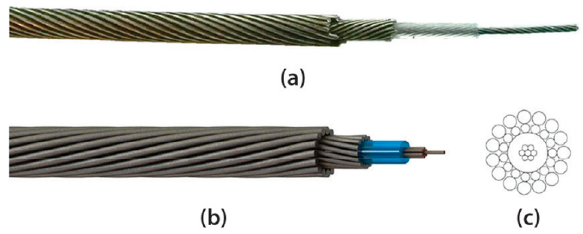
Figure 1. ( a ) Actual 1K22 MP-35N corrosion-resistant cable; ( b ) 1K22 MP-35N CAD model; and ( c